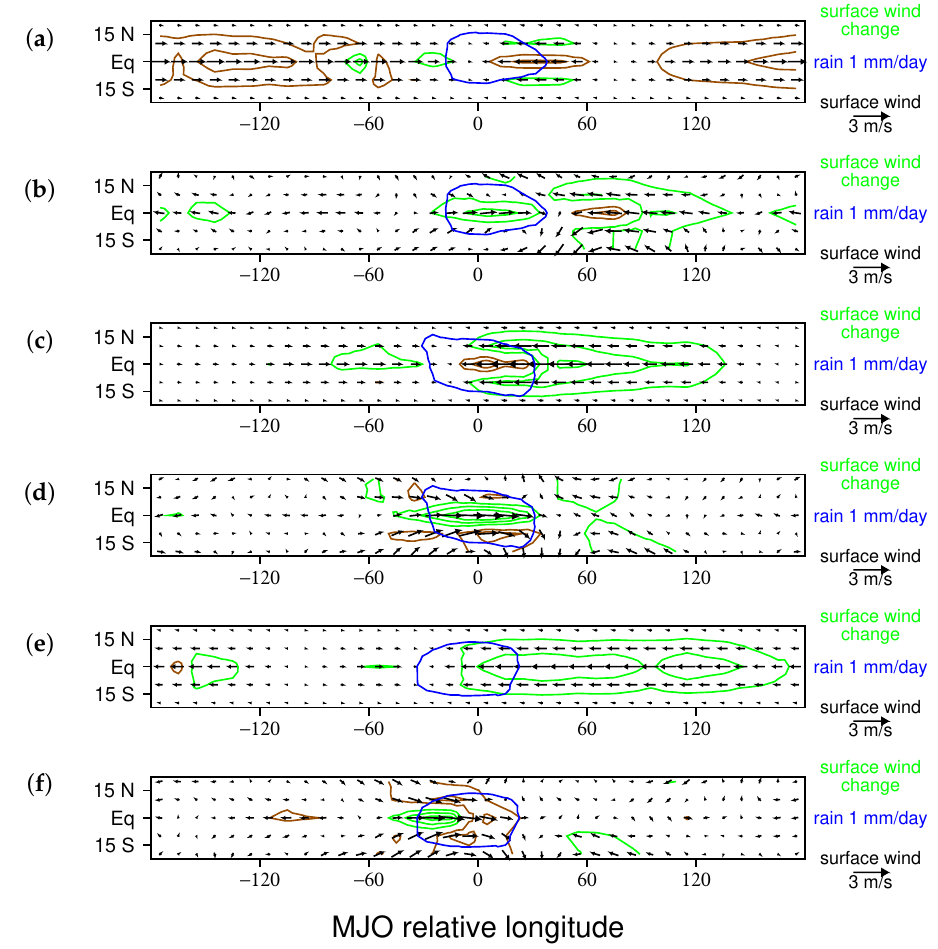
Figure 12. Change in surface wind speed due to Kelvin ( a , c , e ) and Rossby ( b , d , f ) components of the LAM MJO for the developing, mature, and dissipating stages of the MJO, respectively. Green contours indicate regions with enhanced wind speed, and brown contours indicate regions with reduced wind speed (i.e., regions of enhanced and reduced surface fluxes, respectively). The contour interval is 0.5 m/s. Vectors indicate the difference between 850 and 200 hPa flow. The blue contour encloses the region with rain rates greater than 1